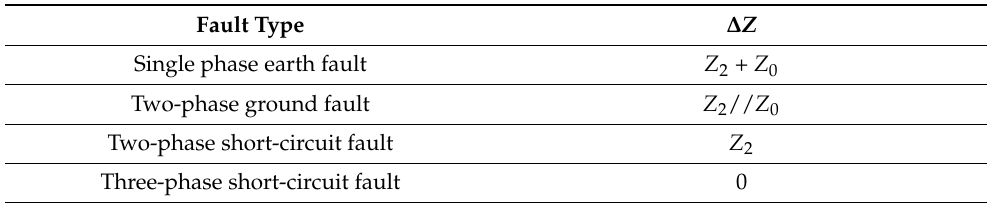
Figure 3d is taken as an example to analyze the positive sequence fault component.